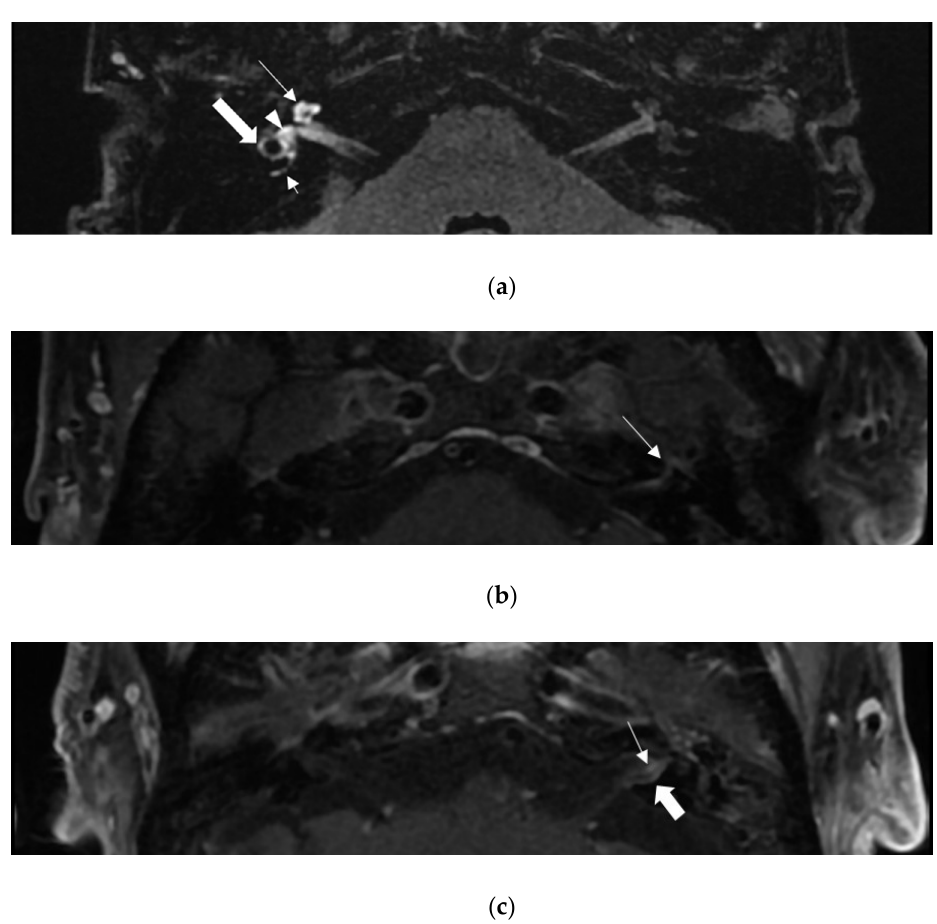
Figure 1. Internal auditory canal (IAC) MRI images of patients with Ramsay Hunt syndrome. Post- contrast 3D-FLAIR MRI of patient 12 ( a ), and post-contrast 3D T1-weighted images of patient 13 ( c ) and patient 9 ( b ). ( a ) High-signal intensities of cochlea (long arrow), posterior semicircular canal (small arrow), lateral semicircular canal (large arrow), and vestibule (arrowhead) were observed in the right ear. ( b ) The labyrinthine segment of the left facial nerve is enhanced (arrow). ( c ) In the left ear, contrast enhancement is observed in the vestibulo-cochlear nerve(small arrow) and the dura of the IAC (large arrow), respectively.